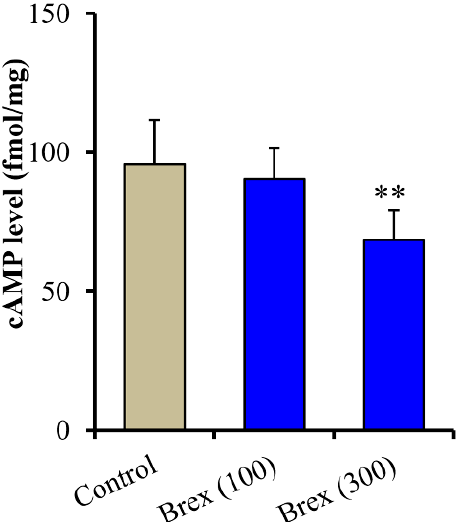
Figure 7. Concentration-dependent subchronic effects of Brex (100 and 300 nM) on intracellular cAMP level in astrocytes. Ordinates indicate mean ± SD ( n = 6) of intracellular cAMP level in cultured astrocytes (fmol/mg). ** p < 0.01: relative to control (Brex-free) by one-way ANOVA with Tukey’s post-hoc test.